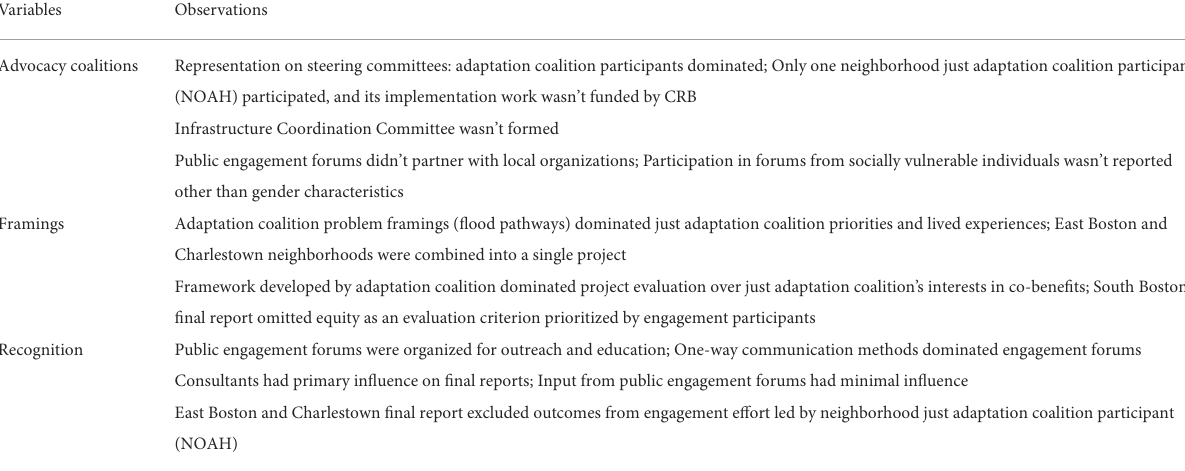
TABLE 5 Evaluation of just adaptation in Climate Ready Boston’s first implementation